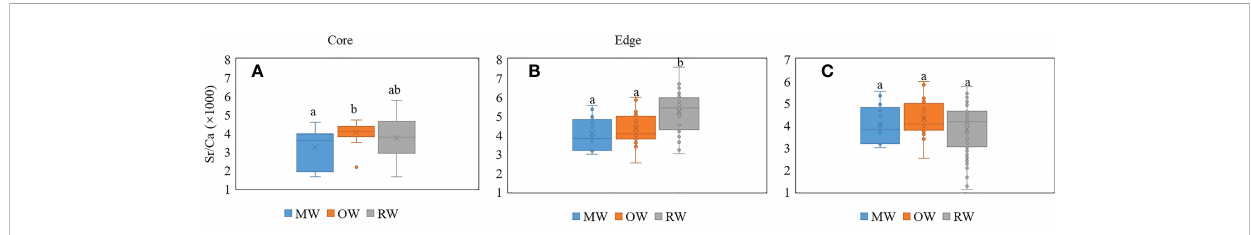
FIGURE 3 Box plot of A. latus otolith edge and core elemental ratios. MW, mangrove habitat waters; OW, oyster farm habitat waters; RW, reef habitat waters. Different letters show signi fi cant differences between sampling sites (P < 0.05). (A) the core, (B) the edge, (C) the RW edge and MW and OW cores. a, b, ab represent differences in each